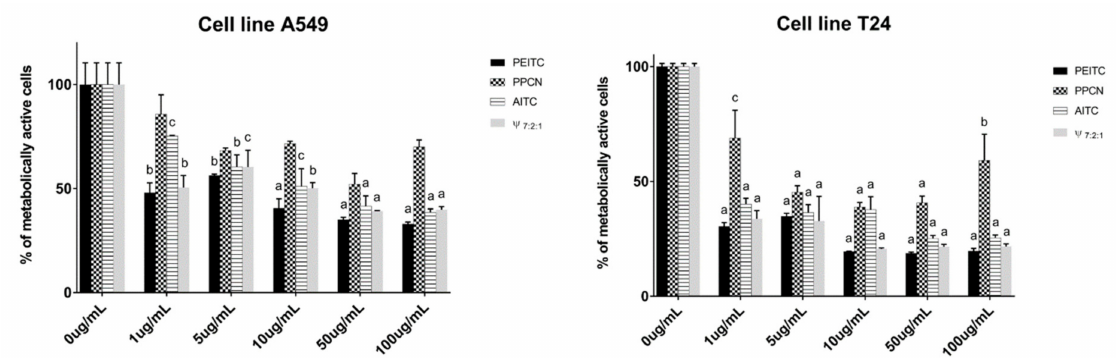
Figure 3. Percentage of metabolically active human lung carcinoma cell A549 and bladder cancer cell T24 lines after 72h of incubation with the main compounds obtained from horseradish isolates (2-phenylethyl ITC, 3-phenylpropanenitrile and allyl ITC) and their mixture (7:2:1, respectively). (n = 3). Lower case letters represent significance level in comparison to non-treated cell line samples (a, p < 0.001; b, p < 0.01; c, p <